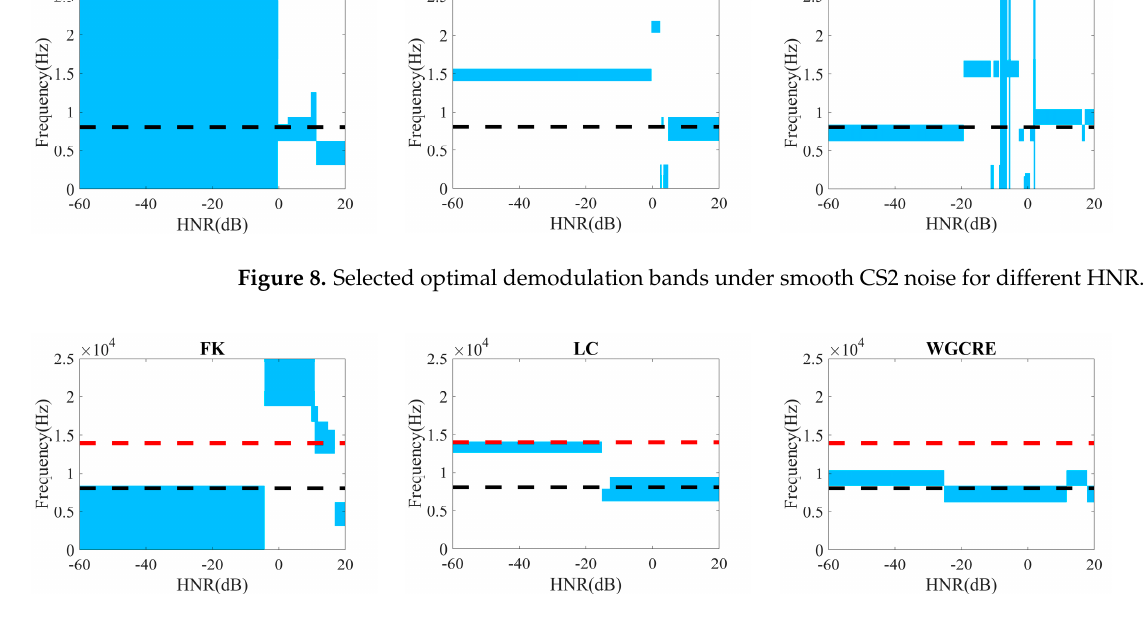
Figure 9. Selected optimal demodulation bands under impulsive CS2 noise for different HNR.